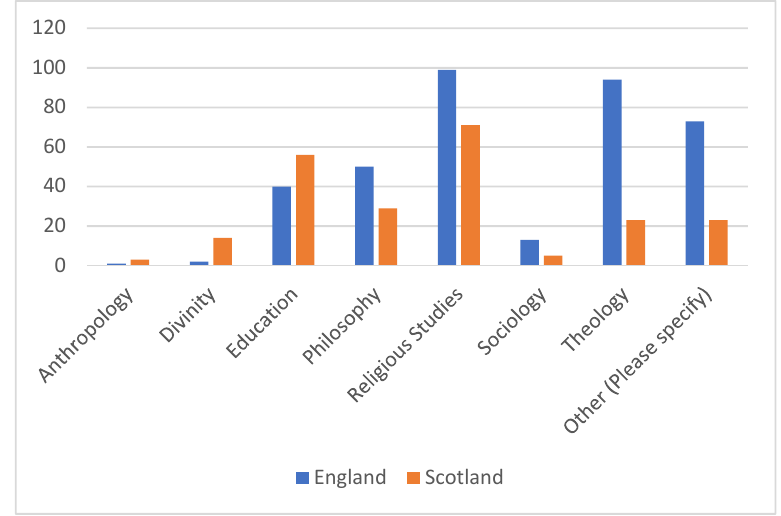
Figure 3. Q6 Degree background (England, Scotland and Secondary only): n = 355.